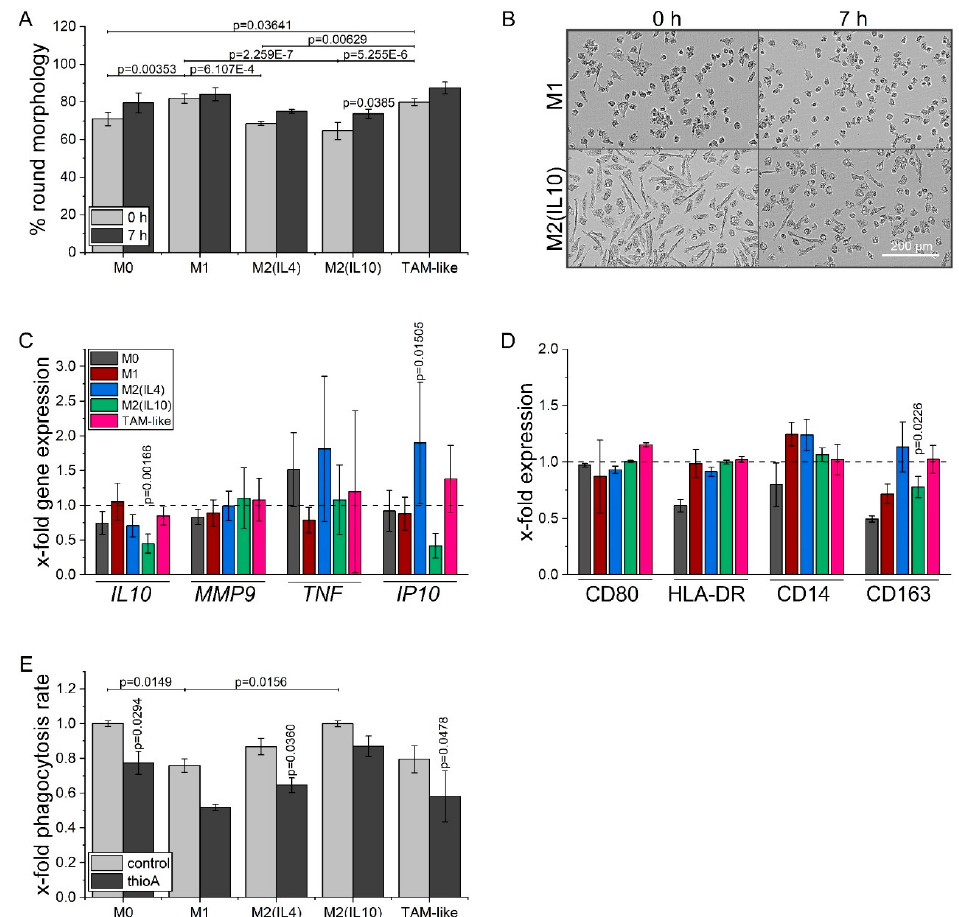
Figure 8. ThioA reduces M2 polarization markers. HMDMs were differentiated and polarized in vitro into M0, M1, M2(IL4), M2(IL10), and TAM-like macrophages for 24 h, followed by 50 nM thioA treatment. Cells were imaged at the beginning and at the end of 7 h treatment using automated microscopy. Cells were grouped based on their eccentricity in an elongated or round phenotype by the IncuCyte cell by cell analysis software ( A ; n = 3 (quadruplicates)). Representative pictures of M1 and M2(IL10) macrophages are shown ( B ). Macrophages polarized for 21 h were treated with 50 nM thioA for 7h. Gene expressions of IL10 , MMP9 , TNF , and IP10 were measured after treatment by qPCR. Expression values were normalized to 18S as a housekeeping gene, followed by normalization to vehicle control-treated cells of the respective polarization state ( C ; n = 3 (triplicates)). Surface marker expression of M1-associated CD80 and HLA-DR, and M2-associated CD14 and CD163 was analyzed by flow cytometry after a 7 h treatment of macrophages polarized for 21 h. Expression values were normalized to vehicle control-treated cells of the respective polarization state ( D ; n = 2 (duplicates)). Macrophages polarized for 24 h were treated with thioA (1 µ M) for 30 min, followed by incubation with fluorescent latex beads for 15 min. The proportion of macrophages that engulfed beads was quantified by flow cytometry. Bead-positive macrophages were normalized to M0 cells of the respective donor ( E ; n = 3 (duplicates)). Statistical analysis was performed using one-way ANOVA followed by Tukey’s post-hoc